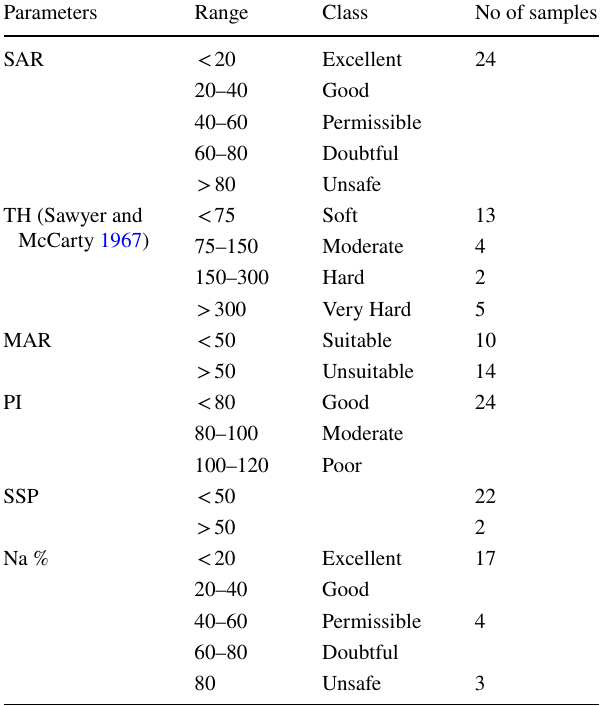
Table 4 Classification of samples according to standards specified Parameters